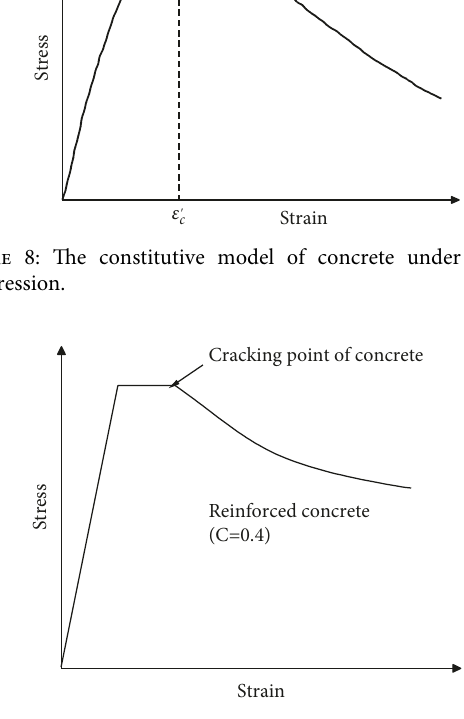
Figure 9: The constitutive model of concrete under uniaxial